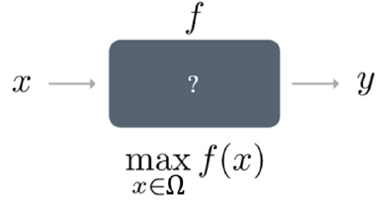
Figure 1. The general scheme of a problem underlying BO. Bayesian optimization is a statistically principled approach to adaptively and sequen- tially select these query points (or batches of query points), which enables an effective trade-off between evaluating f in regions of good observed performance and regions of high